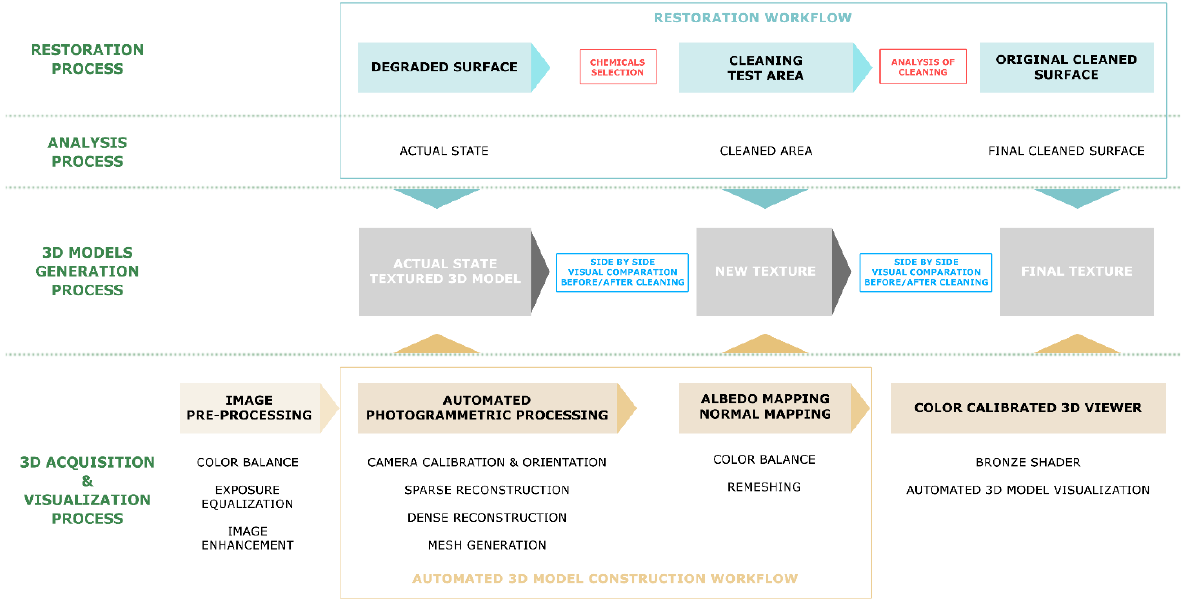
Figure 1. The proposed solution pipeline in parallel with the bronze cleaning